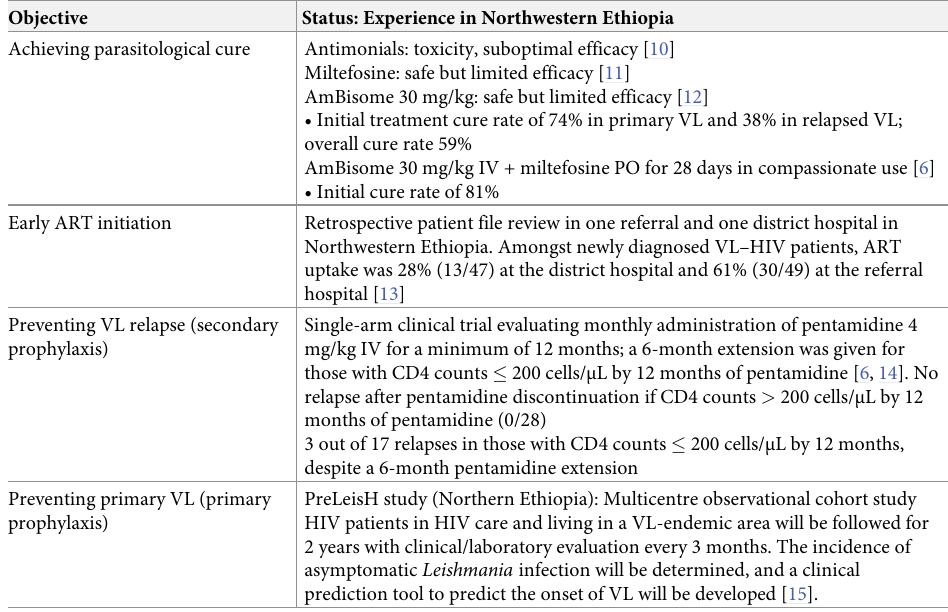
Abbreviations: ART, antiretroviral treatment; CD4, cluster of differentiation 4; IV, intravenously; PO, per os (oral treatment); VL, visceral